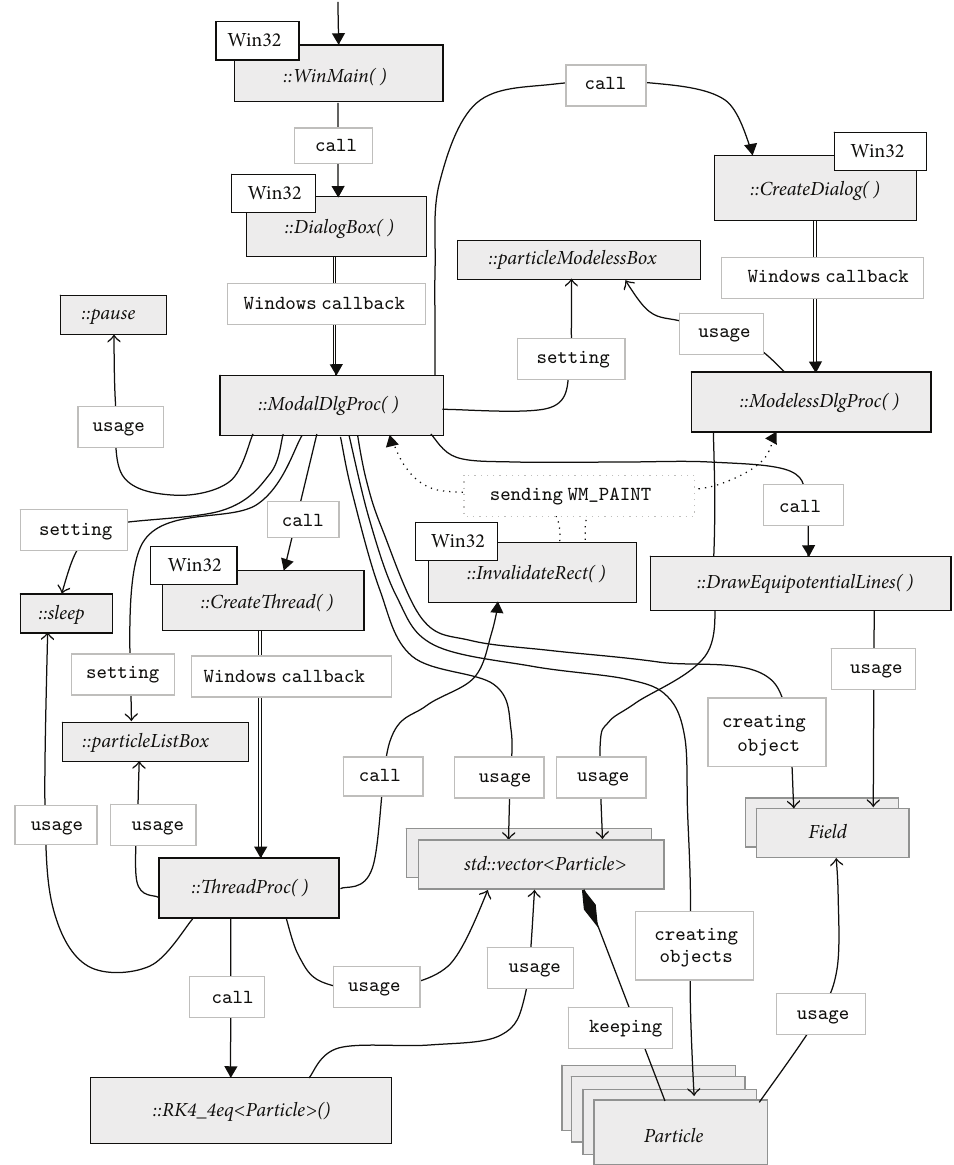
Figure 1: The block diagram showing relationships between classes, objects, functions, and global variables being included in the simulation